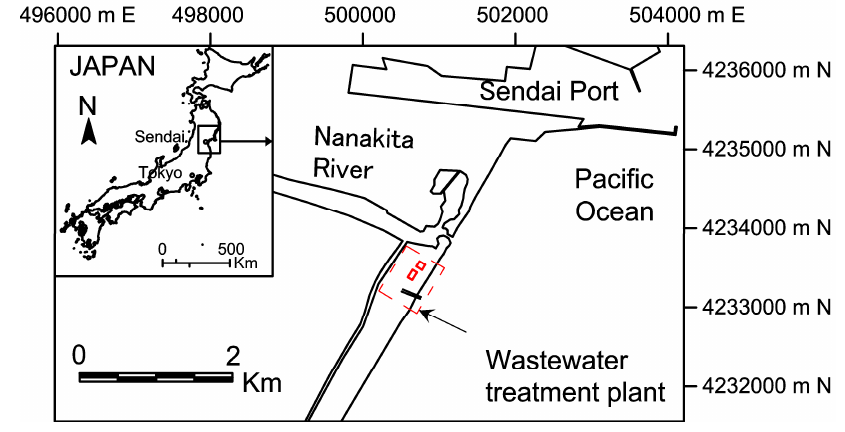
Figure 2. Location map of study area.